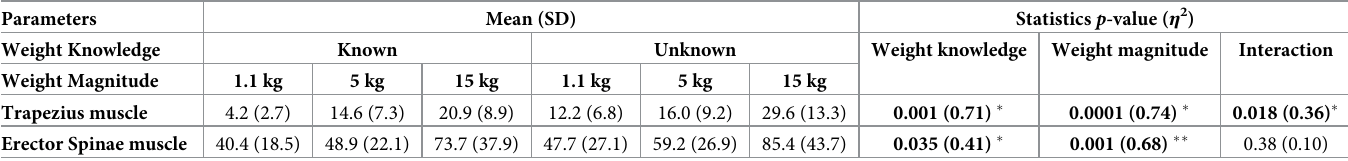
Table 1. Means, Standard Deviations (SD), p -values, and effect sizes ( η 2 ) of the %MVC of both the Trapezius and the Erector Spinae muscles.